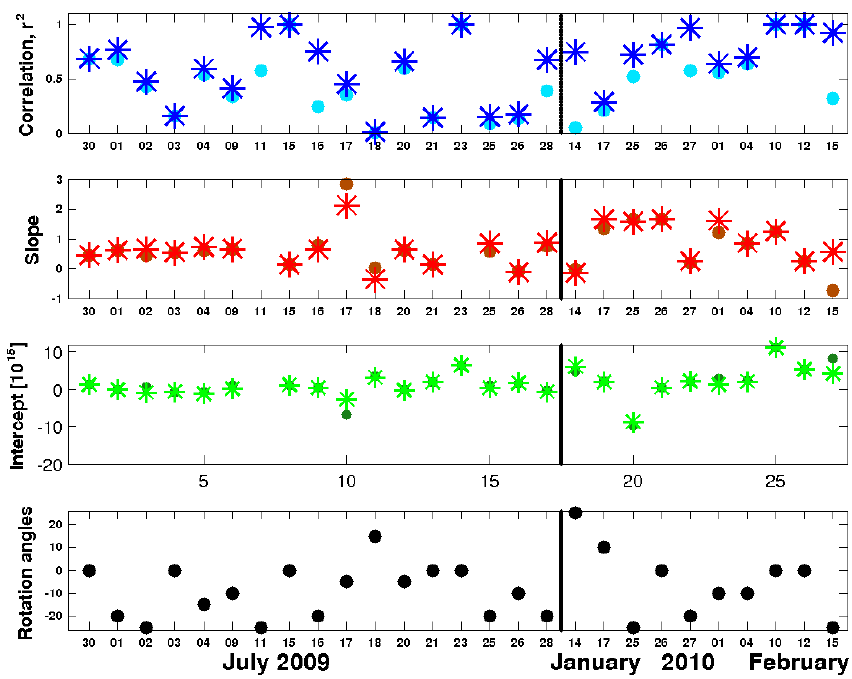
Figure 17. Results of the spatial correlation analyses between CHIMERE and OMI (v2.0 for CF <30%) for individual days (dots: results for original CHIMERE data; stars: results for rotated CHIMERE data). (a) Correlation coefficients; (b) slopes of the regression lines; (c) y axis intercepts; (d) optimum rotation